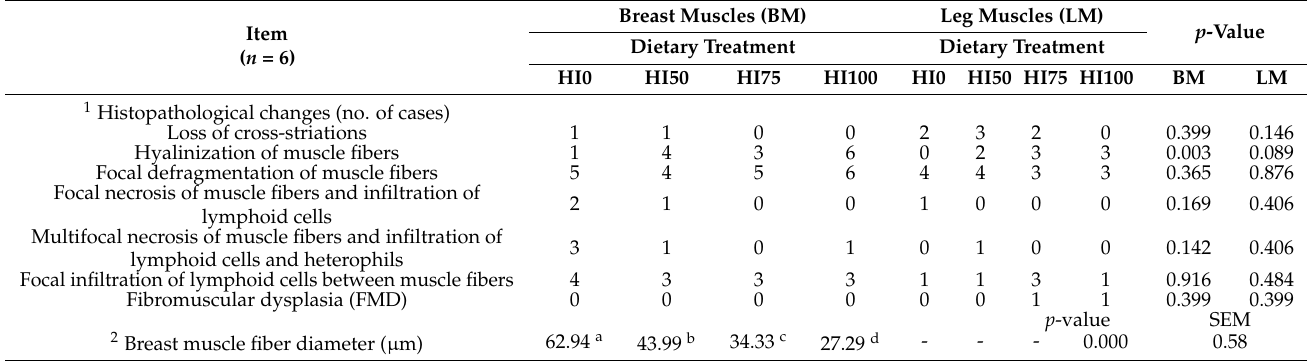
Table 8. Incidence of histopathological changes (number of cases) 1 in breast muscles (BM) and leg muscles (LM) and muscle fiber diameter 2 (arithmetic mean, SEM), in broiler chickens fed diets with different levels of full-fat Hermetia illucens (HI) larvae